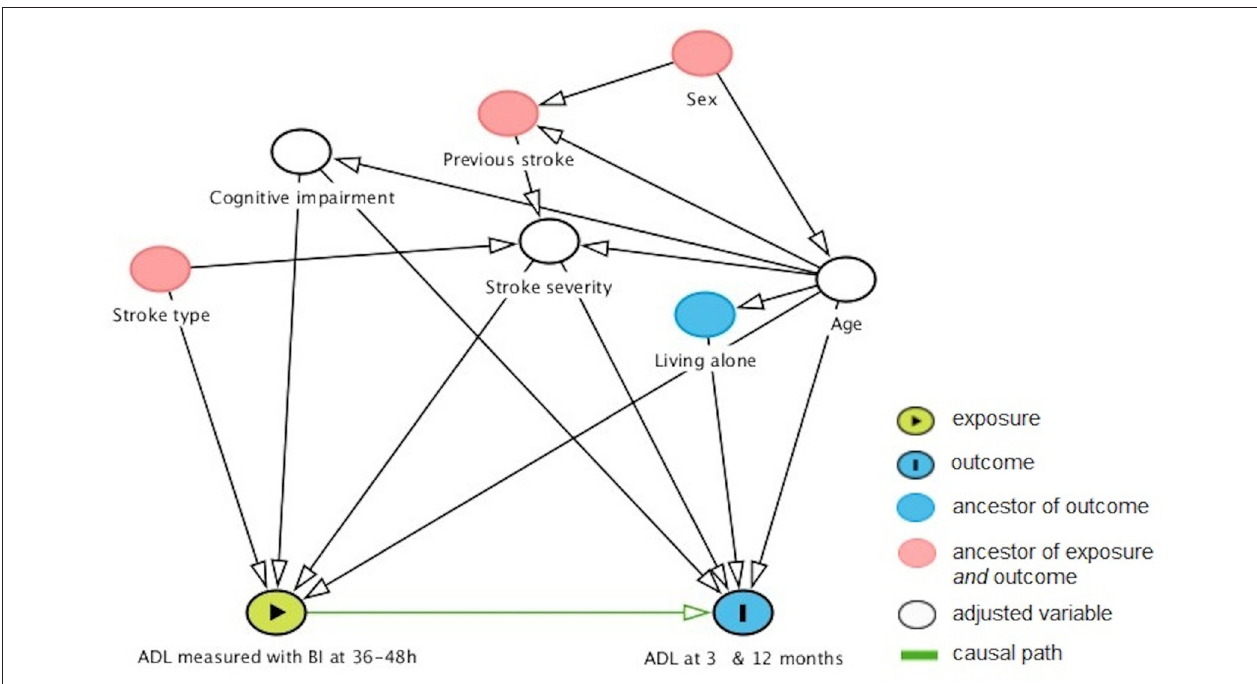
FIGURE 1 | Directed acyclic graph showing factors that might confound the relationship between early and later ADL outcomes. Age, stroke severity, and cognitive impairment were identified as the minimal sufficient adjustment set. ADL, activities of daily living; BI, Barthel Index.